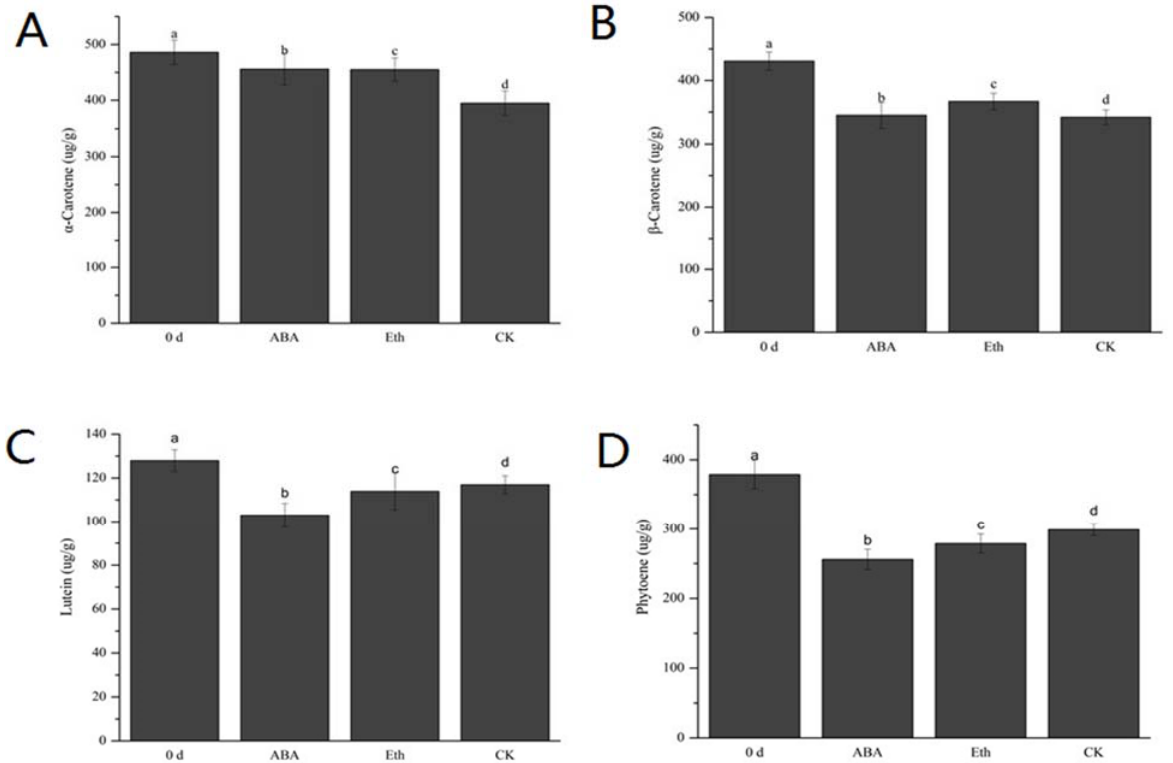
Figure 3. The content of carotenoids in each treatment group of fresh-cut carrot. Eth represents the ethylene treatment group, ABA represents the abscisic acid treatment group, and CK represents the water treatment group. The surface tissues were taken on the 3rd day of carrot extraction. ( A ) Effects of each treatment on α -carotene content, ( B ) Effects of each treatment on β -carotene content, ( C ) Effects of each treatment on lutein content, and ( D ) Effects of each treatment on phytoene content. Each value is presented as the mean ± SE (n = 3). Means with different letters are significantly ( p < 0.05) different between each sample type for different treatment groups.